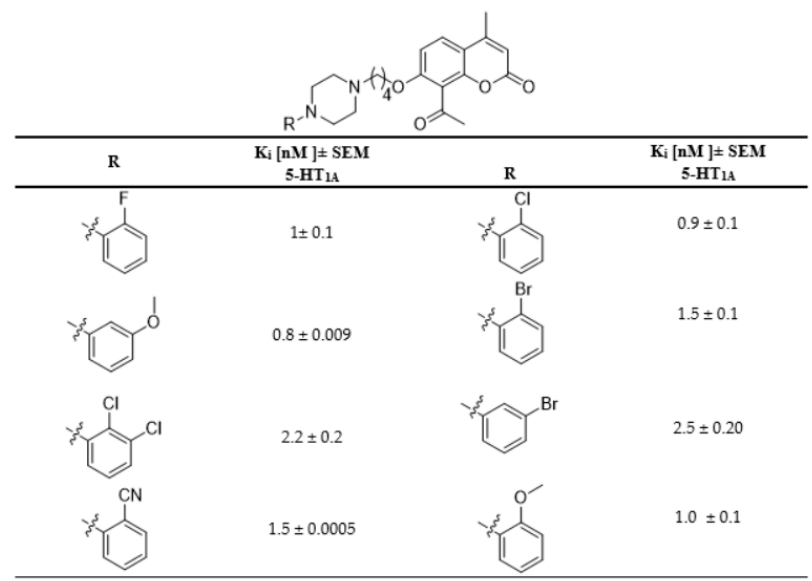
Figure 1. Selected 5-HT 1A receptor affinities of previously synthesized coumarin derivatives.